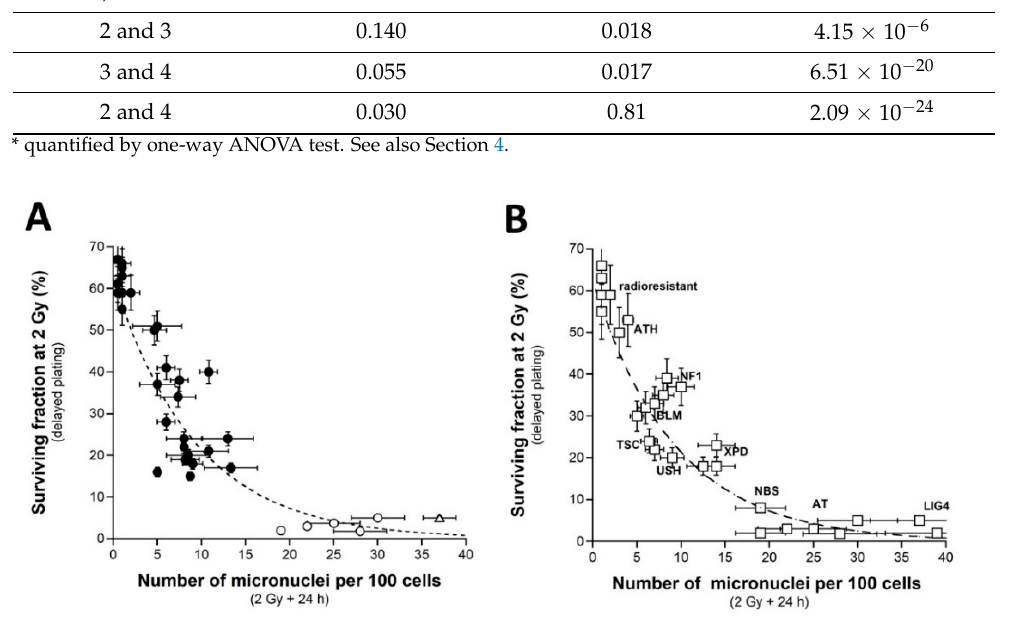
Figure 3. SF2 vs. micronuclei. ( A ) The SF2 data from 36 COPERNIC cell lines were plotted against the corresponding number of micronuclei per 100 cells assessed 24 h post-irradiation (closed circles). Each point corresponds to the mean ± standard error of the mean (SEM) of three independent trip- licates, at least. The best data fit was obtained with the linear law: SF2 (%) = 62.2 exp ( − 0.107 MN 24h ); r 2 = 0.939 (dotted line). The points corresponding to the ATM - (open circles) and the LIG4 - (open triangles) mutated cell lines are indicated. ( B ) The SF2 values (±SEM) and the corresponding num- bers of micronuclei per 100 cells assessed 24 h post-irradiation (±SEM) from fibroblasts deriving from patients suffering from the indicated syndromes (open squares) (AT: ataxia telangiectasia, ho- mozygous mutations of ATM ; LIG4: homozygous mutations of LIG4 ; NBS: Nijmegen’s syndrome, homozygous mutations of NBS1 ; XPD, xeroderma pigmentosum D, homozygous mutations of XPD ; USH, Usher’s syndrome, homozygous mutations of USH; TSC, tuberous sclerosis, heterozygous mutation of TSC ; Bloom’s syndrome, homozygous mutations of BLM ; NF1, neurofibromatosis type 1, heterozygous mutations of neurofibromin; ATH, heterozygous mutations of ATM . The dotted line is the reproduction of the data fit shown in ( A ). The syndromes data were obtained from our lab and published elsewhere [3,15,30,43]. 2.3. Number of H2AX Foci vs. CTCAE Grades and SF2-Micronuclei- γ H2AX Foci Relationships As evoked above, one of the most current ways of assessing DSBs is the immunoflu- orescence assay performed with the anti- γ H2AX antibody [38,41,55–58]. However, while IR “physically” induces about 40 DSBs per Gy in all the human fibroblasts, whatever their radiosensitivity, the number of γ H2AX foci assessed early (10 min) after irradiation may depend on their radiosensitivity [43]. The nuclear γ H2AX foci have been associated with the DSBs recognized by the ATM-dependent non-homologous end-joining (NHEJ), the most predominant DSB repair and signaling pathways in human quiescent cells [38,41,55– 58]. In human radioresistant quiescent fibroblast cell lines, about 40 nuclear γ H2AX foci per Gy per cell have been currently scored early after irradiation. This value was found similar to those deduced from other techniques assessing DSBs, which strongly supports that the anti- γ H2AX immunofluorescence permits to detect the great majority of RI DSBs as far as the NHEJ pathway is predominant in the cells tested [3]. However, in radiosen- sitive cells, the amount of DSBs recognized by NHEJ was shown to be lower than the number of DSBs “physically” induced by IR [42,43], suggesting an impairment in the DSB recognition by NHEJ in these cells [42,43]. We, therefore, examined the number of early and residual γ H2AX foci in the 200 COPERNIC cells. The COPERNIC cells have been exposed to 2 Gy X-rays followed by 10 min, 1, 4 (not shown), and 24 h for repair. No significant correlation was found between spontaneous γ H2AX foci and CTCAE grades, in agreement with previous data [43]. The number of γ H2AX foci assessed 24 h post-irra- diation (H2AX 24h ) was plotted against the corresponding CTCAE grade (Figure 4). In agreement with the literature, the radioresistant controls showed the lowest H2AX 24h [41]. Cells from ATM -mutated patients did not show γ H2AX foci (since the phosphorylation of H2AX is strongly ATM-dependent) or, if any, γ H2AX foci were found very tiny and